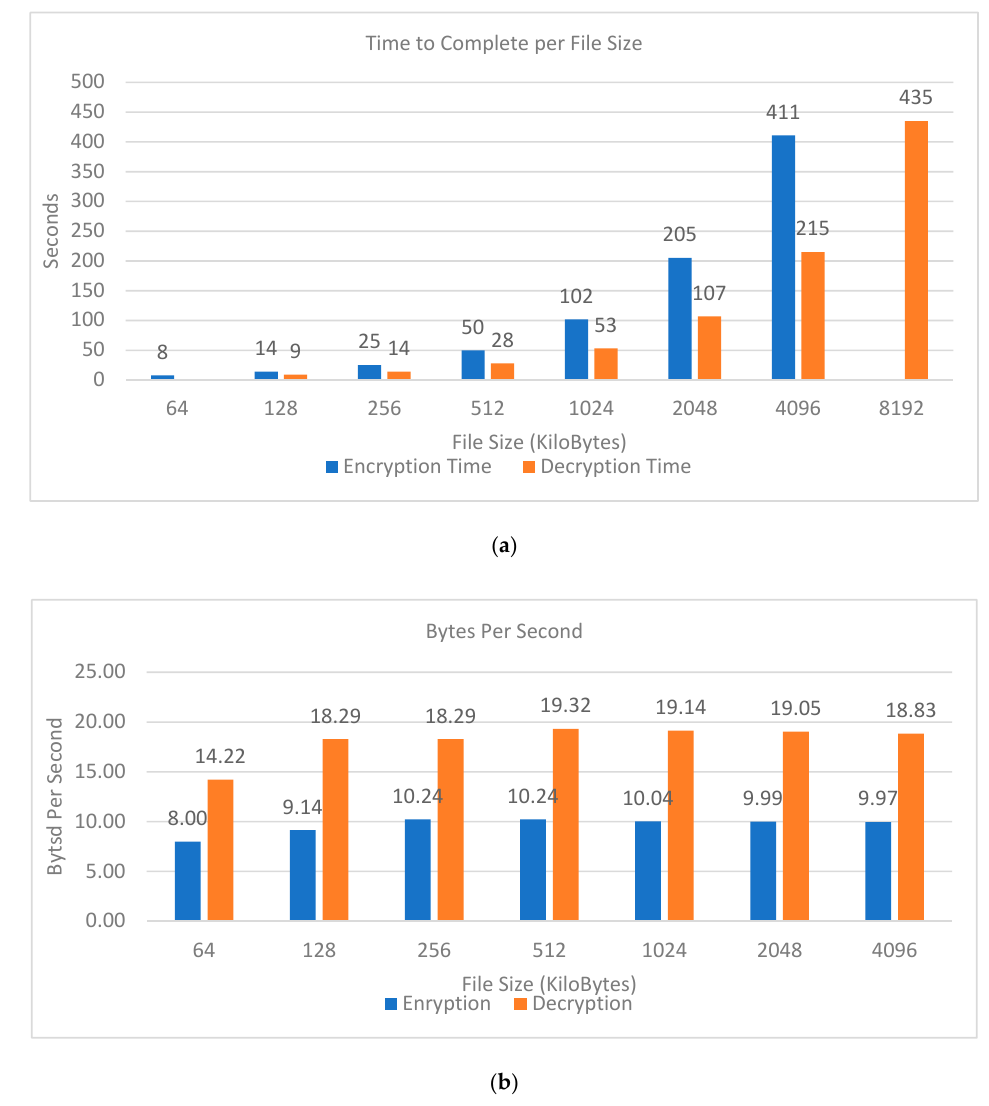
Figure 7. Performance with varying file size yields predictable outcomes: ( a ) a doubling in file size consistently yielded a near doubling in runtime; ( b ) bytes per second remains near constant for all file size tests with exception of smallest file size.